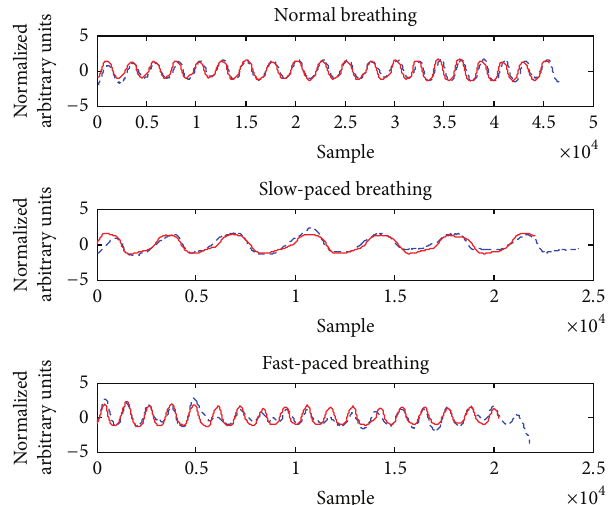
Figure 7: Demonstration of the ADR signal (dashed line) which is following well the reference signal in different breathing patterns.